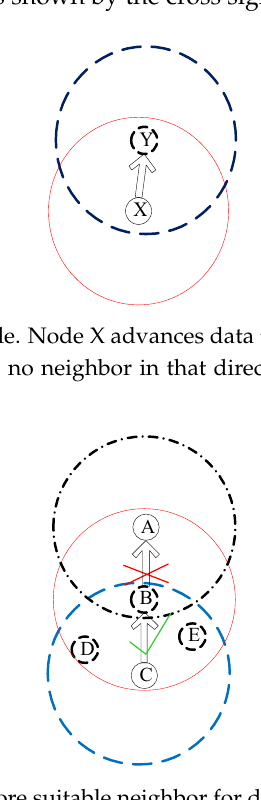
Figure 5. Node C finds Node B a more suitable neighbor for data routing than D and E due to lower water pressure on B and a second hop Node A as the neighbor of B. Tick signs confirm data forwarding from C to B. For B, A is not a suitable neighbor for routing due to it not having any neighbor with lower water pressure (depth) than A, which confirms a void-hole beyond A. The cross sign indicates avoidance of data routing from B to